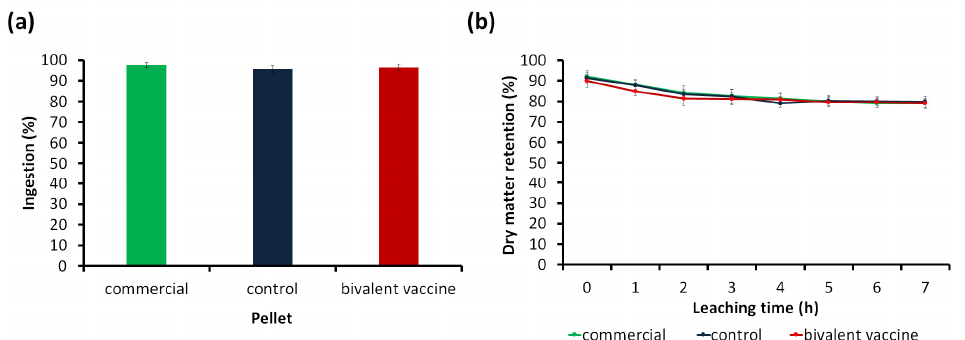
Figure 2. Palatability and physical stability of the pellets. ( a ) The ingestion percentage of commercial tilapia and formulated (control and bivalent vaccine) pellets; ( b ) the percentage of dry matter retention over leaching time for commercial tilapia and formulated (control and bivalent vaccine) pellets using the static water method. Results are the average triplicate ± standard deviation data (error bar). Insignificant different ( p ≥ 0.05) between treatments.